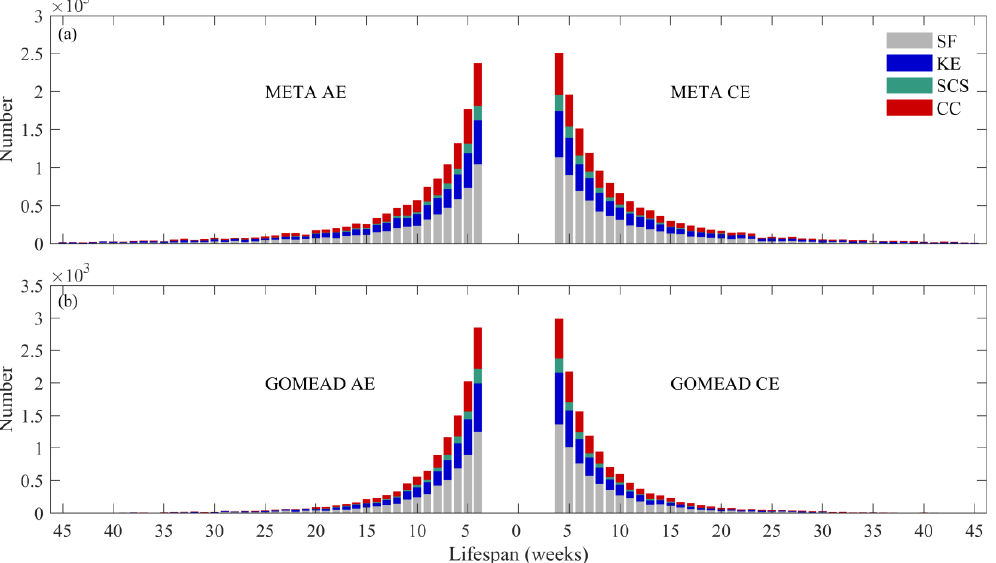
Figure 4. Histograms of eddy lifespans, ( a ) META; ( b ) GOMEAD.